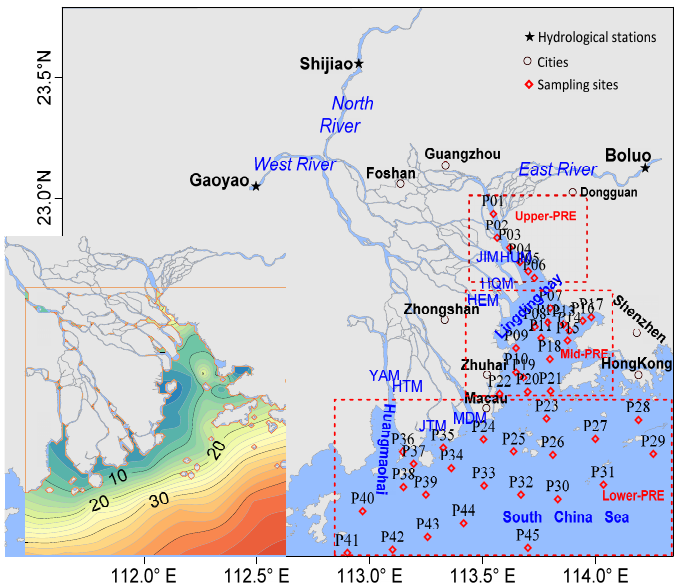
Figure 1. Sketch map of the Pearl River estuary (PRE) and adjacent coastal waters. The PRE consists of three major rivers (east, north, and west rivers), discharging waters to the South China Sea via eight outlets at Humen (HUM), Jiaomen (JIM), Hongqili (HQM), Hengmen (HEM), Modaomen (MDM), Jitimen (JTM), Hutiaomen (HTM), and Yamen